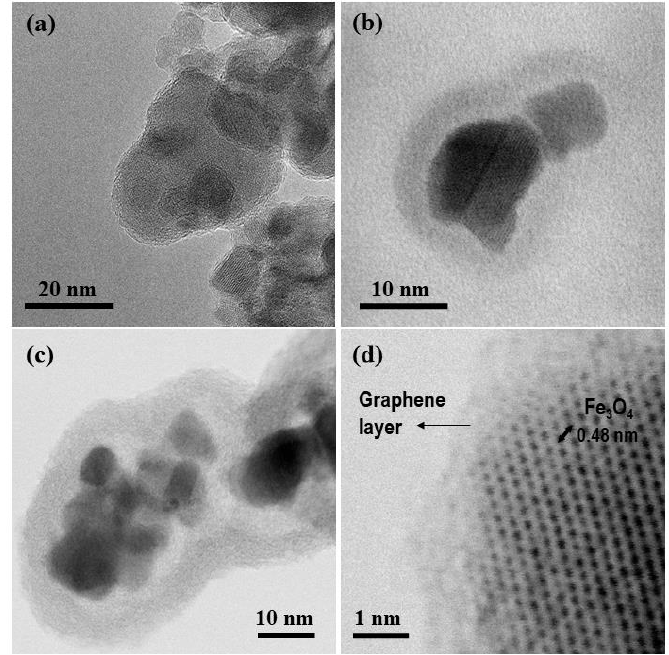
Figure 2. The high-resolution transmission electron microscopy (HR-TEM) bright field images of samples: ( a ) GbMNP-1; ( b ) GbMNP-2; ( c ) GbMNP-3; and (d) the detail of the magnetic core of iron oxide covered by a few graphene layers in sample GbMNP-2.